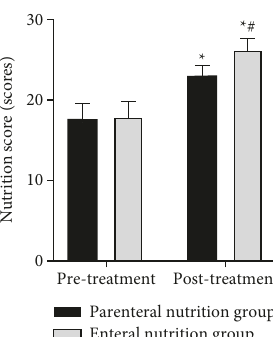
Comparison with the same ∗